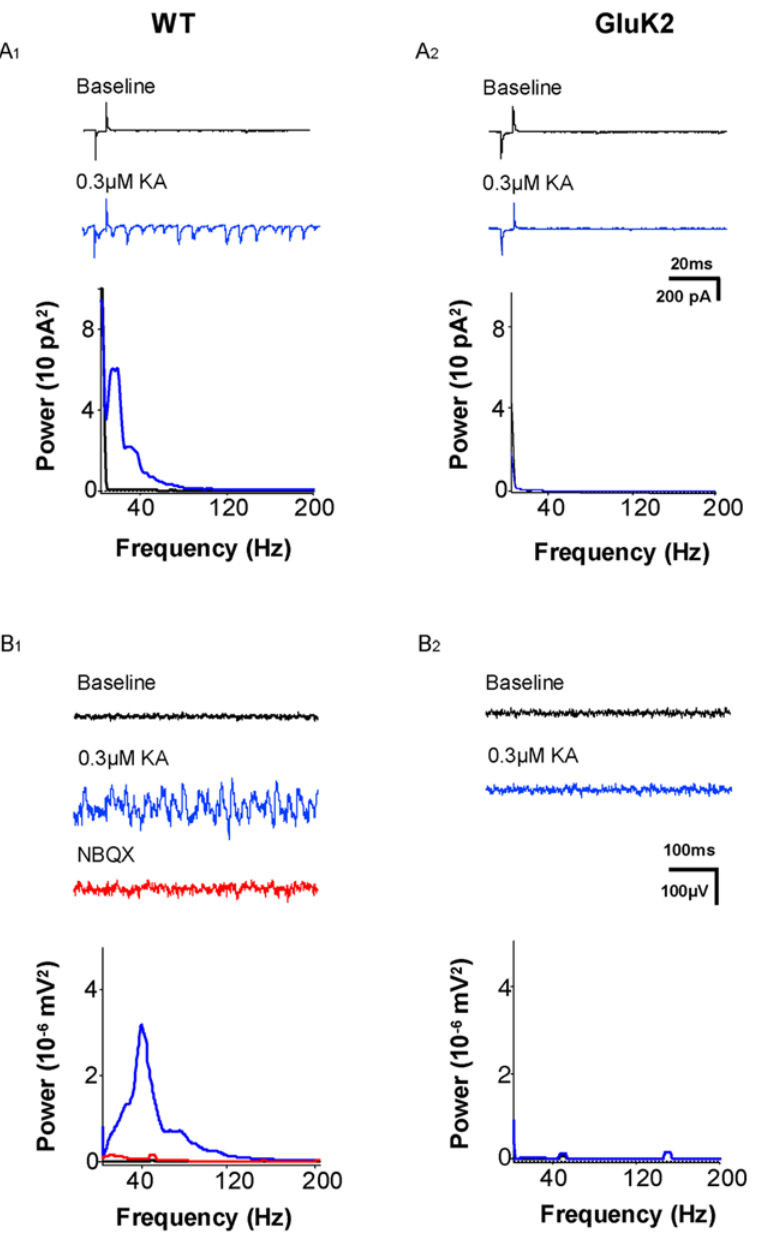
Figure 6. Role of GluK2 in network synchrony. (A 1 ) Rhythmic postsynaptic currents were recorded from WT mice (n=7) following the application of 300 nM KA which had a frequency content of about 10–12 Hz. (A 2 ) In comparison such a synchronised increase in spontaneous postsynaptic currents was absent in the GluK2 KO mice (n=7). (B 1 , B 2 ) Local field potential recordings within the superficial layers of the entorhinal cortex were done in an interphase chamber to record KA-induced gamma oscillations. (B 1 ) Low concentrations of KA (300 nM) induced robust oscillations (n=8 slices). Power spectra analysis revealed a major peak frequency of 40 Hz. The KA-induced gamma oscillations were blocked by the KAR/AMPAR-antagonist NBQX.